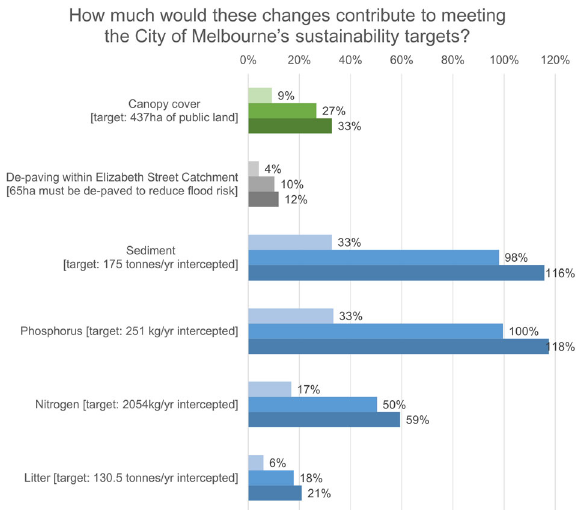
Fig. 4 Summary of policy impacts of parking replacement, showing the impact of each scenario as a proportion of the total change required to deliver the relevant sustainability target. The canopy target is from the City of Melbourne Urban Forest Strategy 77 . The de-paving target is from the Elizabeth Street Catchment Strategy, which covers a highly urbanised, fl ood-prone watershed within the central city 43 . Sediment, Litter and Phosphorus targets are articulated in the city ’ s 2009 Total Watermark strategy 86 . The Nitrogen target is from a 2014 iteration of the same strategy 78 . Figure 4 does not show quantitative progress towards an ecological connectivity target; the city ’ s biodiversity strategy simply seeks an improvement in connectivity overall by 2027 79 . Our modelling indicates that this is possible under most scenarios (Fig.